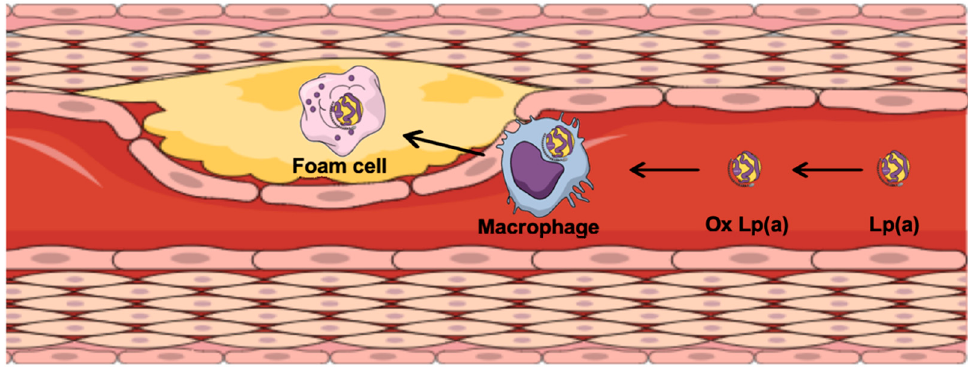
Figure 1. The role of lipoprotein(a) (Lp(a)) in plaque formation. Ox Lp(a), oxidized Lp(a).